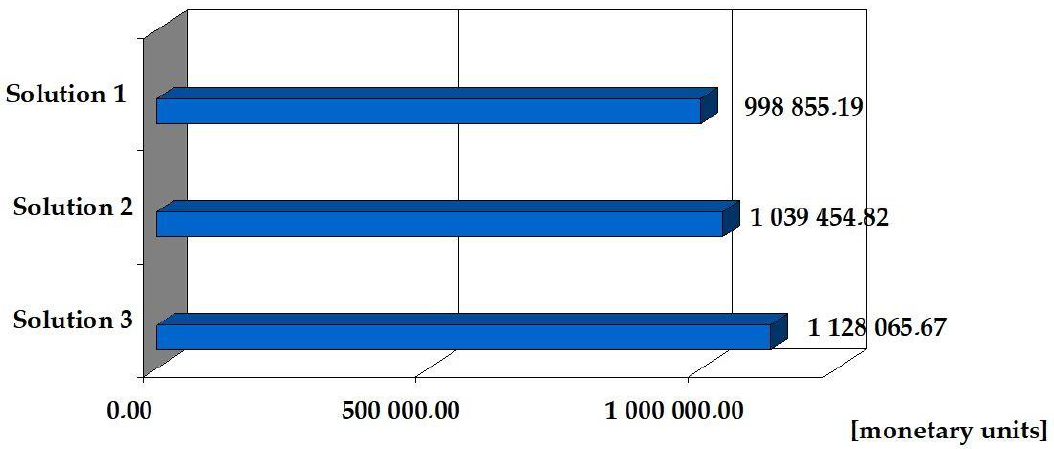
Figure 4. Cost of making walls, ceilings and stairs in the building implemented according to three solutions.